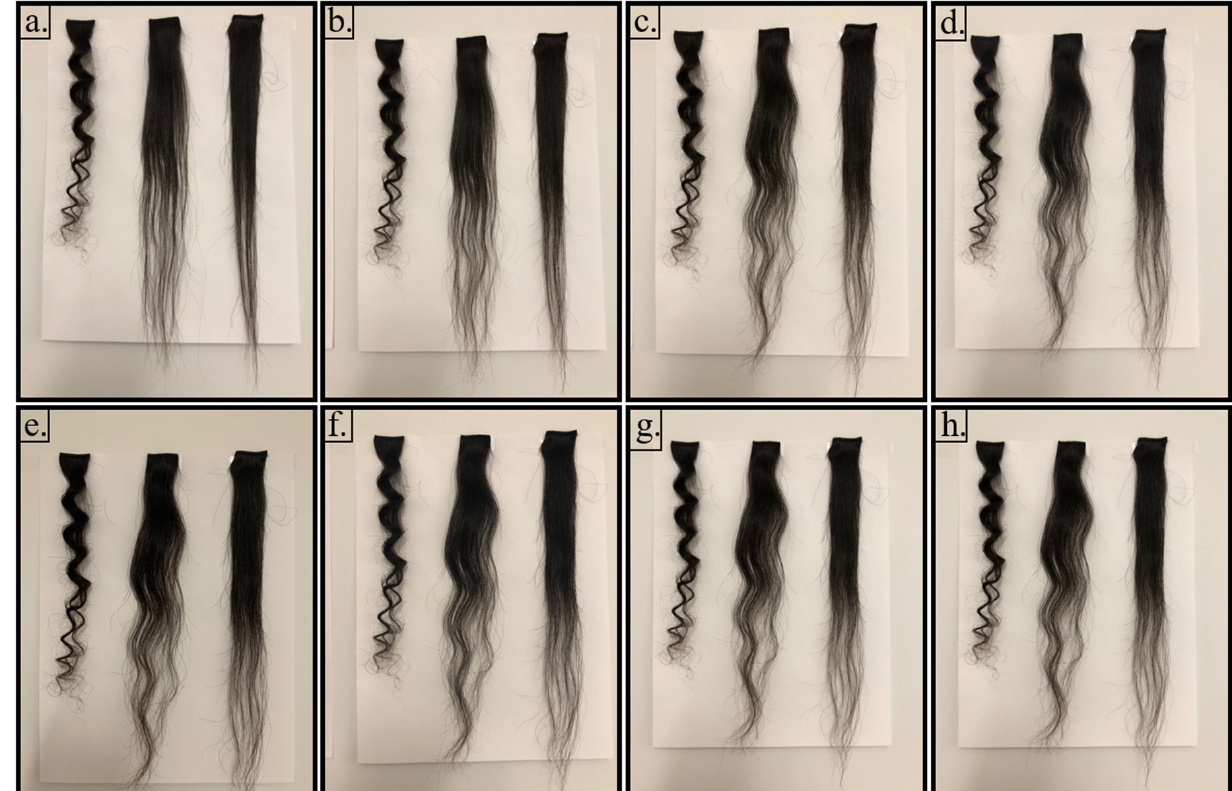
Figure 2. C, FI, and STA hair swatches from left to right in each picture after conditioning at ( a ) day 0, ( b ) day 1, ( c ) day 2, ( d ) day 3 ( e ) day 5, ( f ) day 7, ( g ) day 10, and ( h ) day 15.